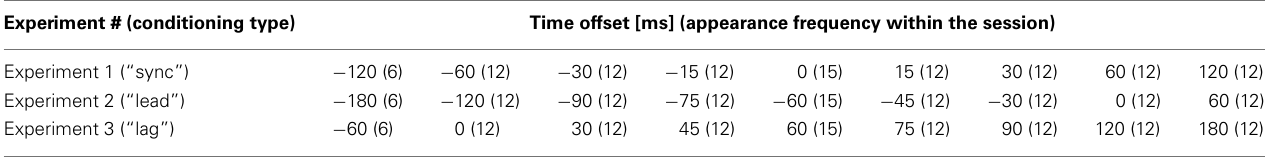
Table 1 |Time offset values and frequencies in the SimultaneityTest